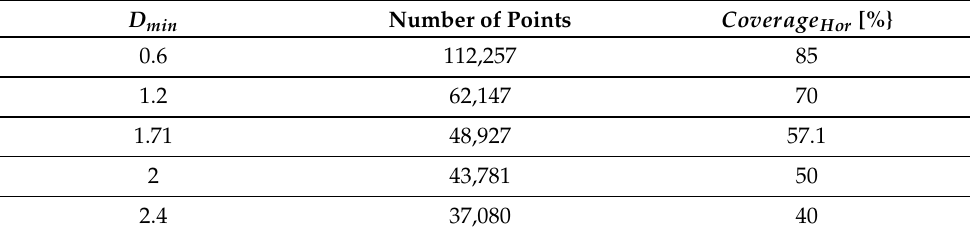
Table 5. Comparison between the variation of D min and its impact on the amount of points of 3D Reconstruction.